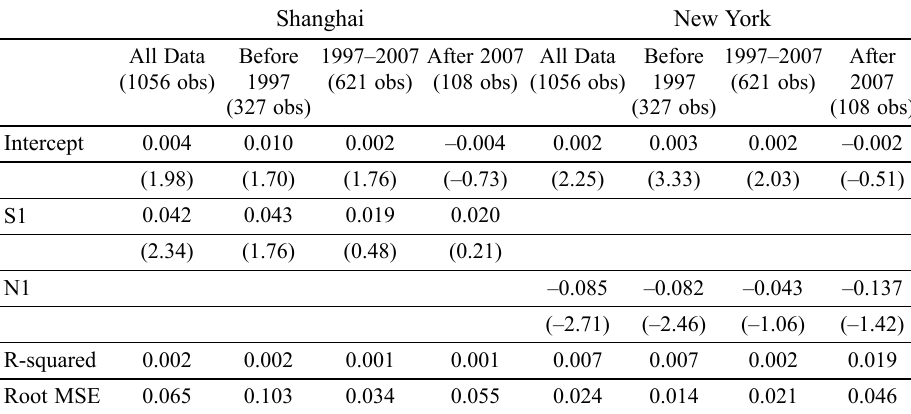
Table 6. Auto regressions of rate of return of Shanghai and New York stock prices The table presents the auto regressions of rate the return of Shanghai and New York stock prices in total sample and three subsamples: before 1997, after 1997 and before 2007, and after 2007. The rate of return is calculated as the change in the natural logarithm of the price index in a given period. The volatility of returns is calculated as the absolute value of the change in the natural logarithm of the price index in a given period. The price index is obtained from DataStream Equity Indices. S1 represents the one-lag of the rate of return of Shanghai stock prices while N1 represents the one-lag of the rate of return of New York stock prices. We also report R-squared and Root MSE. T -statistics are provided in the parentheses. The sample period is from